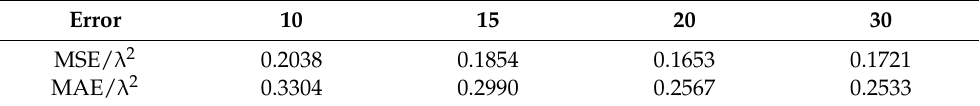
Table 5. Mean square error and mean absolute error of Power on different time steps.